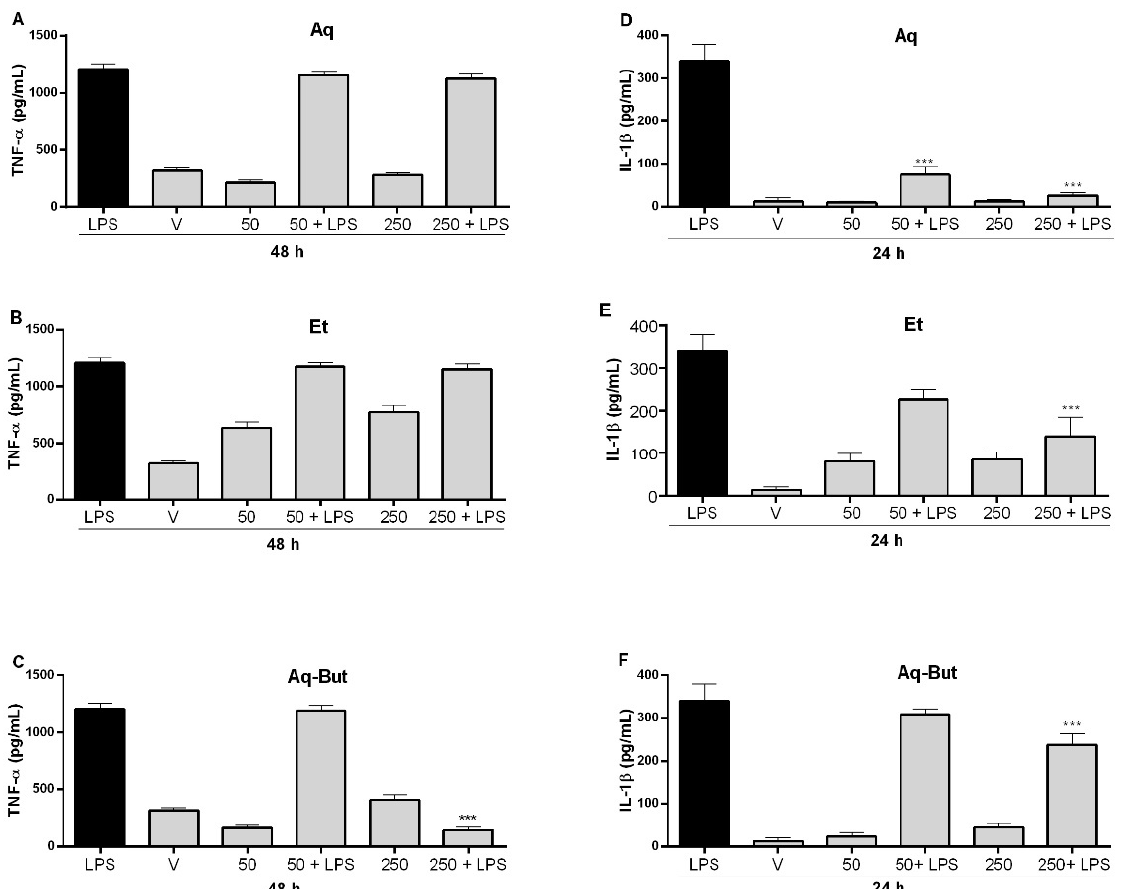
Figure 8. Effects of M. albicans treatment of THP-1 macrophages on the levels of TNF-α ( A – C ) and IL-1β ( D – F ). Statistical analyses were performed by one-way analysis of variance (ANOVA), followed by Bonferroni’s test, for selected pairs. Results represent the mean ± SD of two independent experiments ( n = 3); *** p < 0.001 versus control (LPS). On the other hand, the IL-10 cytokine, which tends to increase in anti-inflammatory environments [23], did not show any differences after treatment with M. albicans extracts during the evaluated incubation periods (Figure